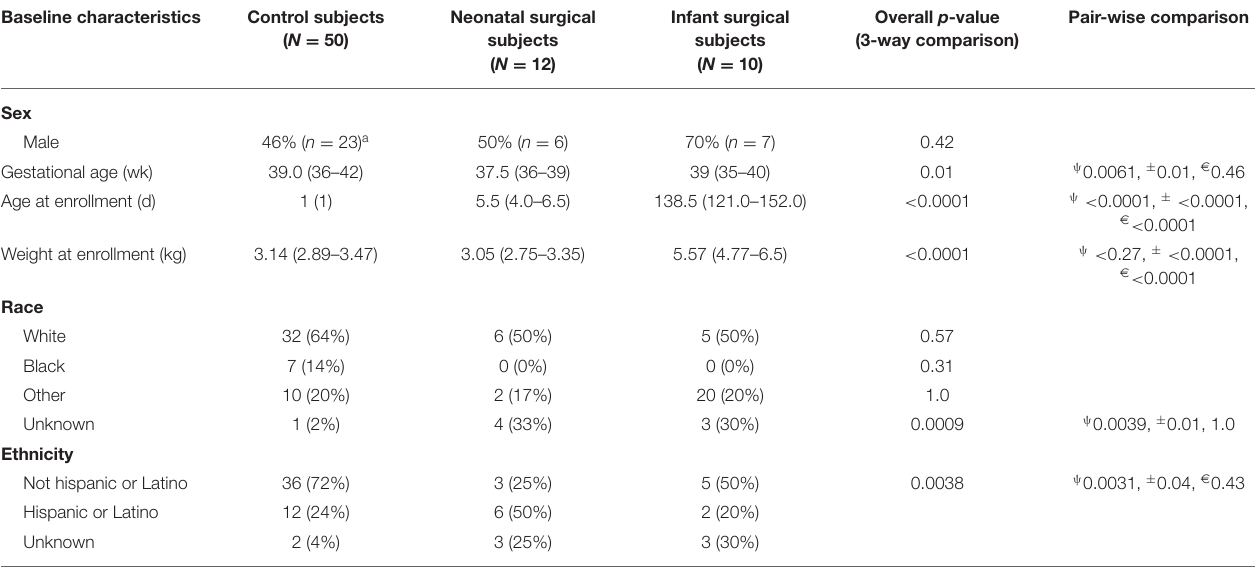
TABLE 1 | Baseline characteristics.